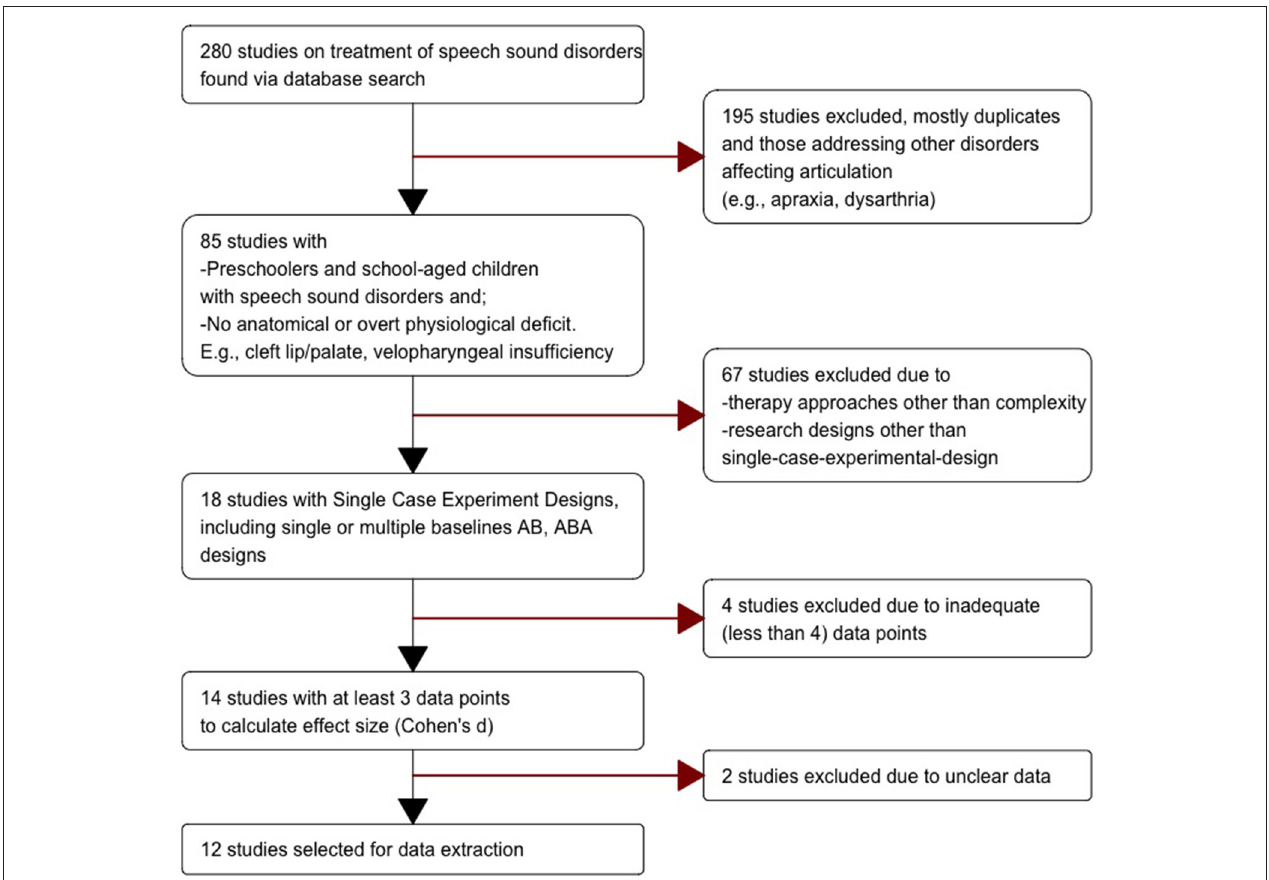
FIGURE 1 | PRISMA chart showing the process of study identification for meta-analysis.